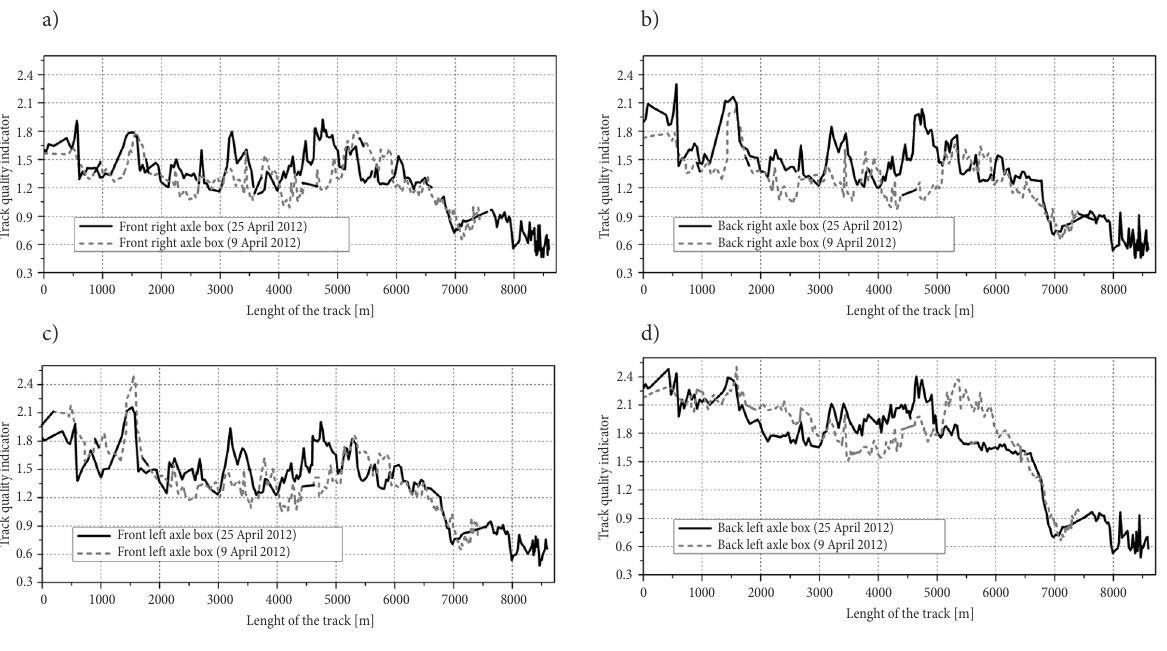
Fig. 12. The diagram for